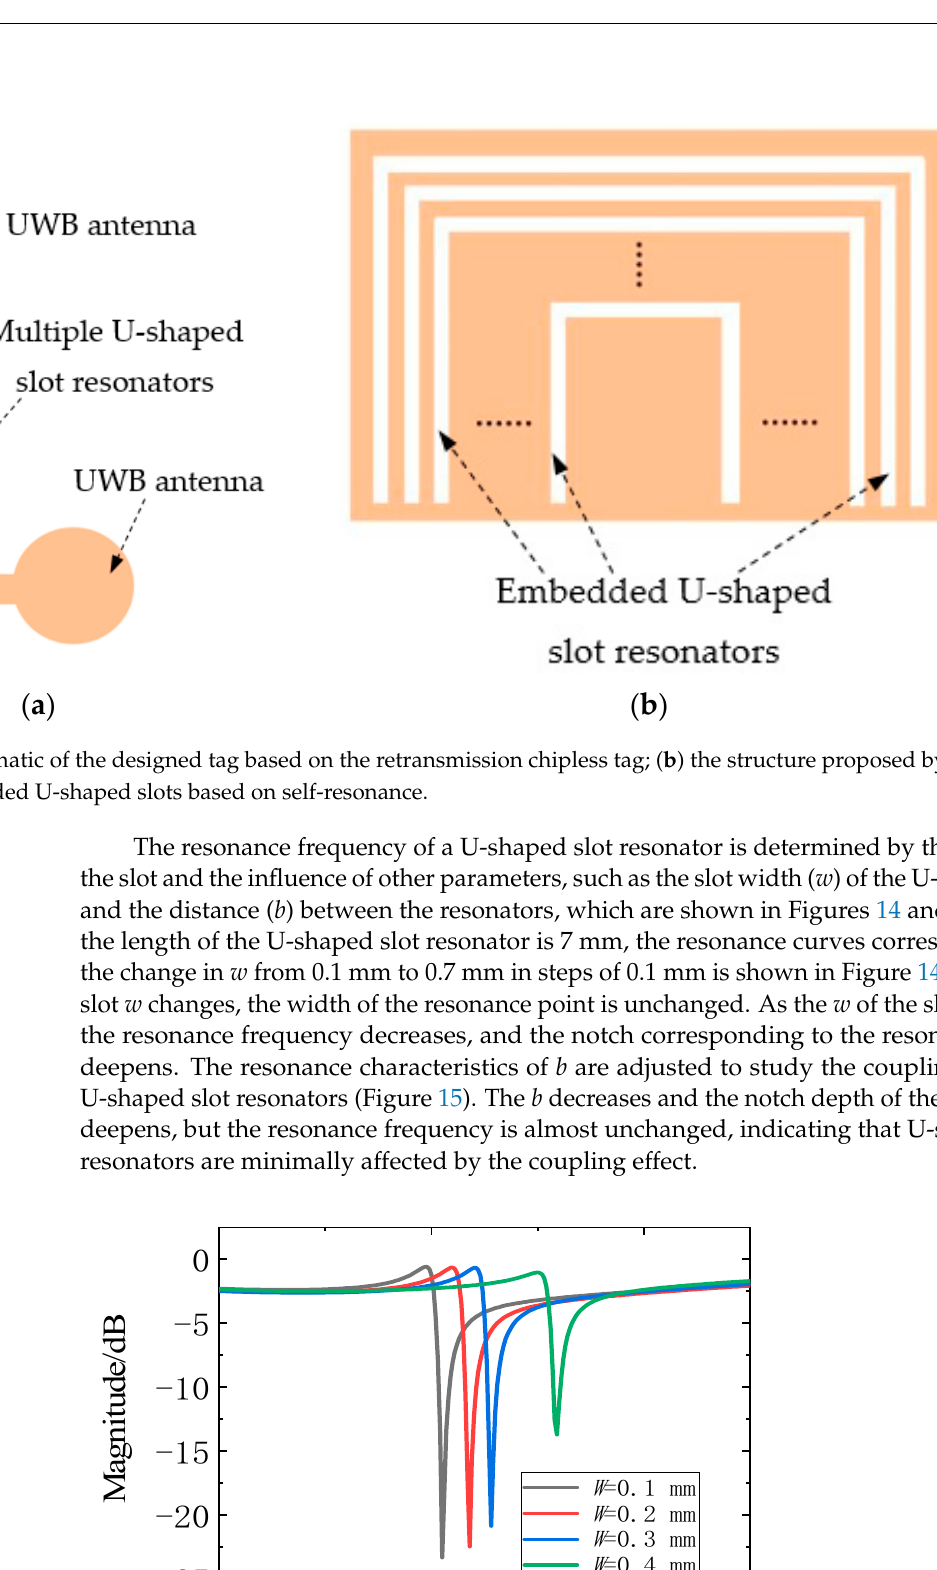
( d ) Figure 12. Simulation and measurement results of U-shaped slot resonator chipless tags: ( a ) ID111111; ( b ) ID101010; ( c ) ID010101; ( d ) ID111000. 5. Discussion The U-shaped slot resonator is used in retransmission chipless tag RFID systems. It brings a lot of advantages to this design. To compare it to other similar work, Figure 13 shows the schematic diagrams of our design and the other U-shaped slot chipless tag [34]. Our work is shown in Figure 13a. Md Aminul Islam et al. [34] used embedded U-shaped slots based on self-resonance. The electric field must be excited along the di- rection of the U-shaped slot opening. In our work, the Rx UWB antenna received the in-